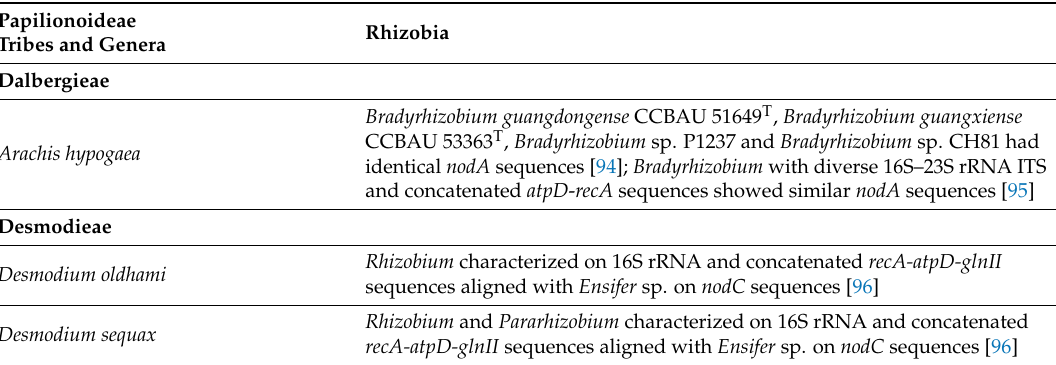
Table 4. Legume–rhizobia symbioses of species in the sub-family Papilionoideae with determinate nodules. Papilionoideae Tribes and